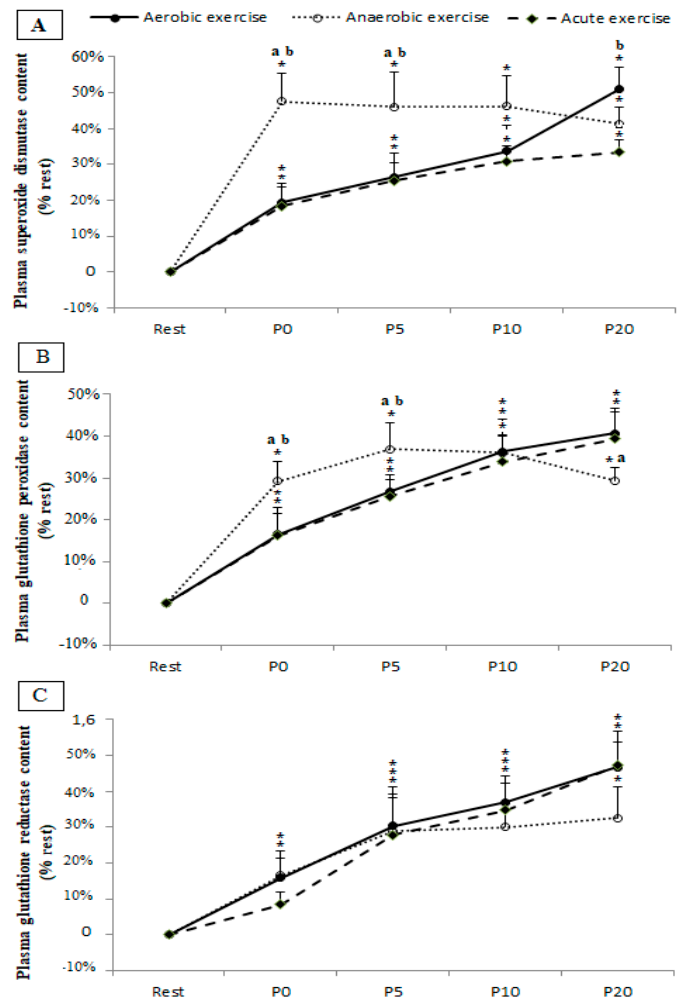
Figure 2. Superoxide dismutase (panel A ), plasma glutathione peroxidase (panel B ), and glutathione reductase (panel C ) content before (Rest), immediately after (P0), and 5 (P5), 10 (P10), and 20 (P20) min after aerobic, anaerobic, and combined (anaerobic and aerobic) exercise. Data are expressed as the % change from pre-exercise resting concentrations. *, **, ***: significant di ff erence when compared to the pre-test values at the level of p < 0.05, p < 0.01 and p < 0.001 respectively; a: significant di ff erence when compared to the aerobic exercise; b: significant di ff erence compared to the combined (anaerobic and aerobic)